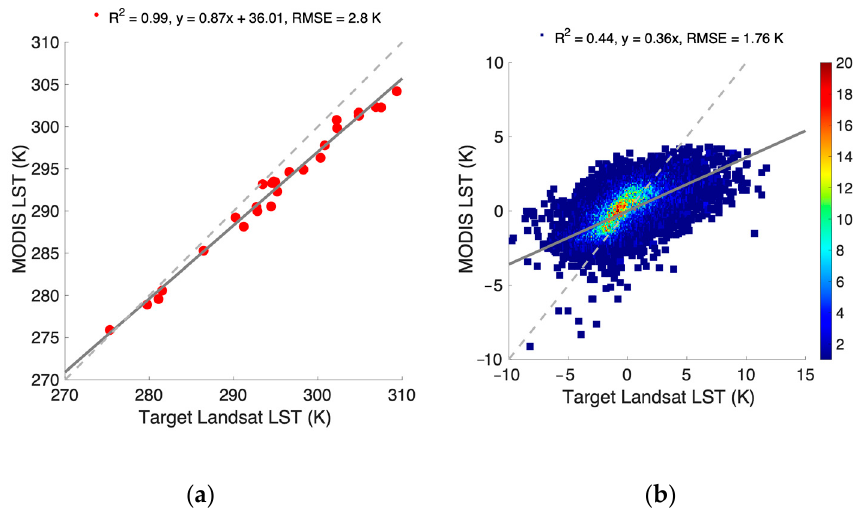
Figure 3. Comparisons of LST at difference scales. ( a ) Comparison of scene-scale mean between MODIS and Landsat LST. ( b ) Comparison of patch-scale LST deviation from the scene mean between MODIS and Landsat. Color in ( b ) indicates data density, presented by number of pixels within each 0.1-K bin. The solid grey lines show the linear fitting functions with statistics noted and the dashed grey lines indicate the 1:1 relationship.